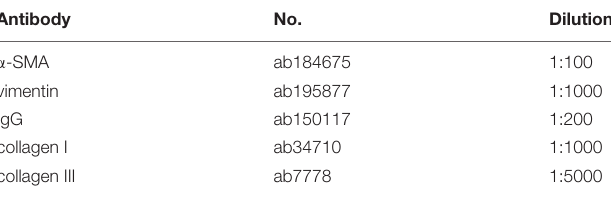
TABLE 3 | Antibodies used in immunocytochemistry and immunofluorescence. Antibody No. Dilution α -SMA